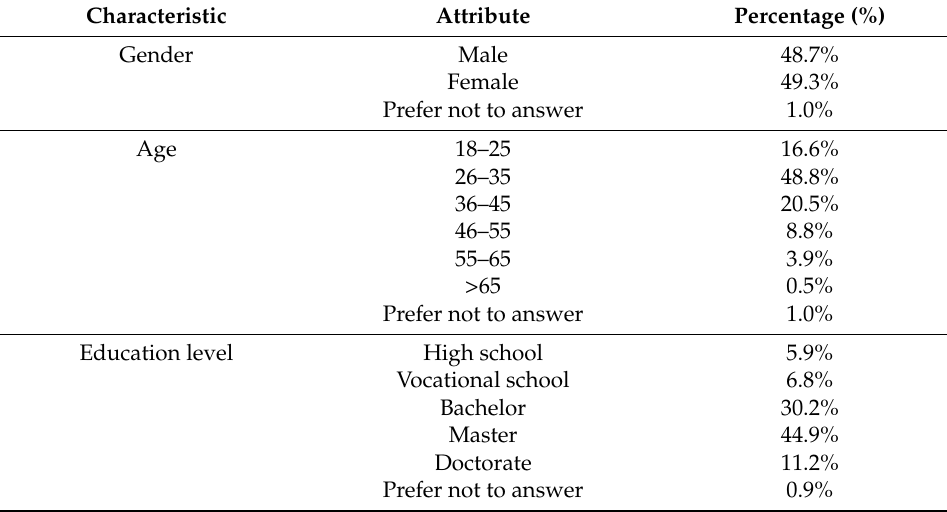
Table 2. General characteristics for survey